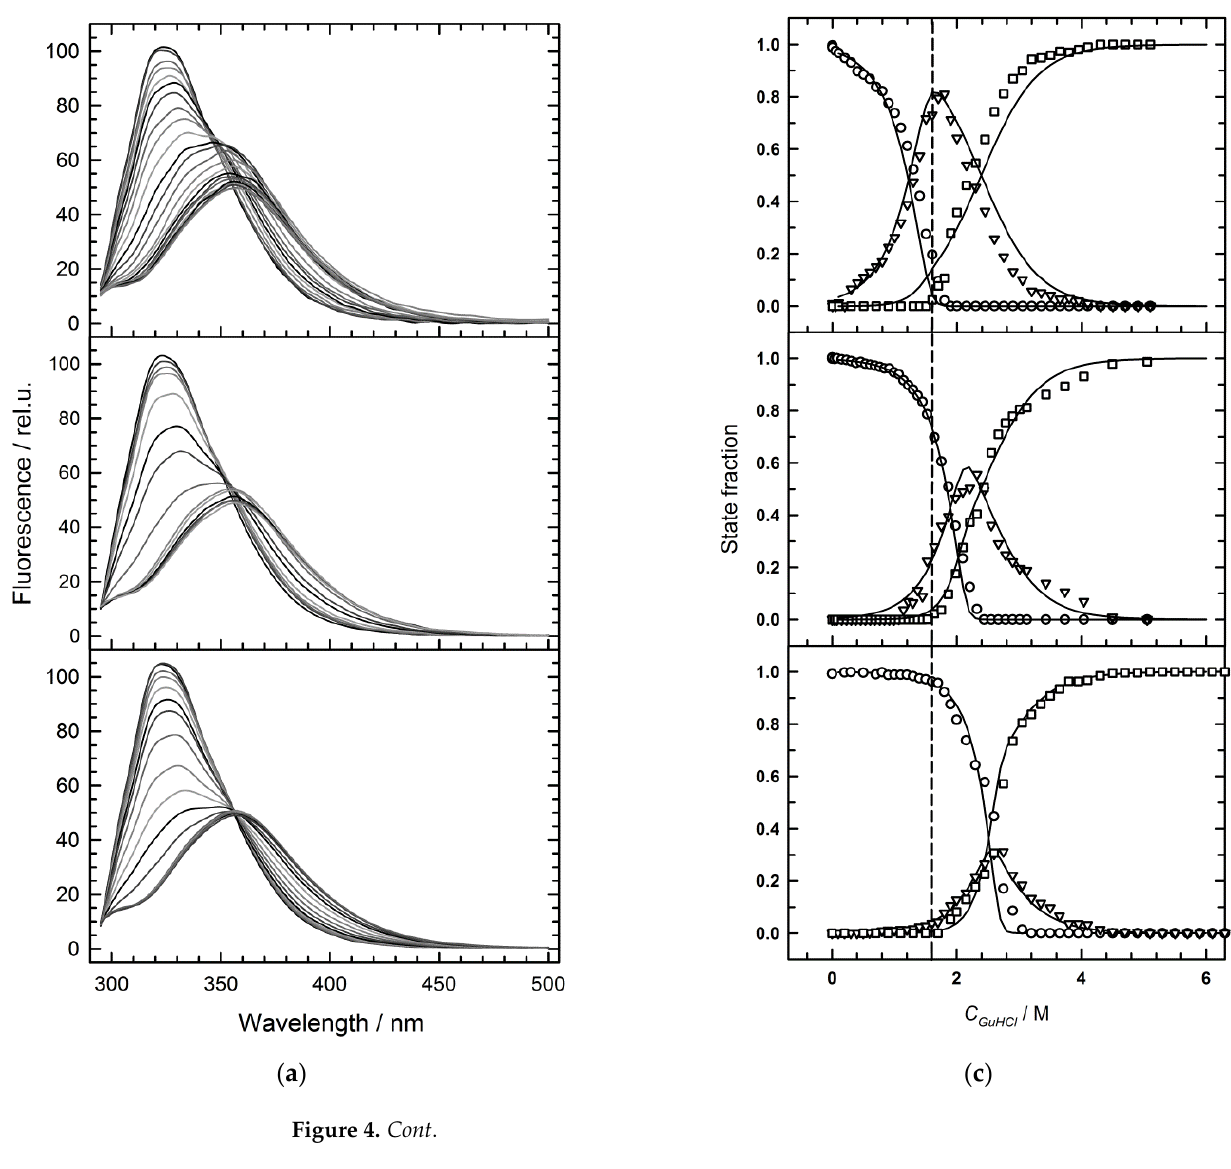
( d ) Figure 4. Analysis of the GuHCl-induced unfolding at various Hfq Y55W concentrations: ( a ),A set of selected Y55W fluorescence spectra recorded within the 0 ÷ 5 M GuHCl range (from top to bottom, grayscale) at three protein (monomer) concentrations: 0.8 (top), 6.5 (middle), and 65 μ M (bottom); ( b ) The GuHCl dependence of the spectrum mass center values (Equation (1)) for three Hfq Y55W concentrations. Circles stand for 0.8 μ M, squares for 6.5 μ M, and triangles for 65 μ M. The black symbols represent results of refolding of Hfq Y55W; ( c ) The GuHCl concentration dependences of the state fractions, as derived from the deconvolution of Y55W fluorescence spectra at three protein concentrations: 0.8 (top), 6.5 (middle), and 65 μ M (bottom). Symbols show: hexamer, circles; intermediate, triangles; and unfolded monomer, squares; while solid lines represent simulations based on the three-state unfolding model (3), Equations (3)–(11), and the parameters from Table 2.